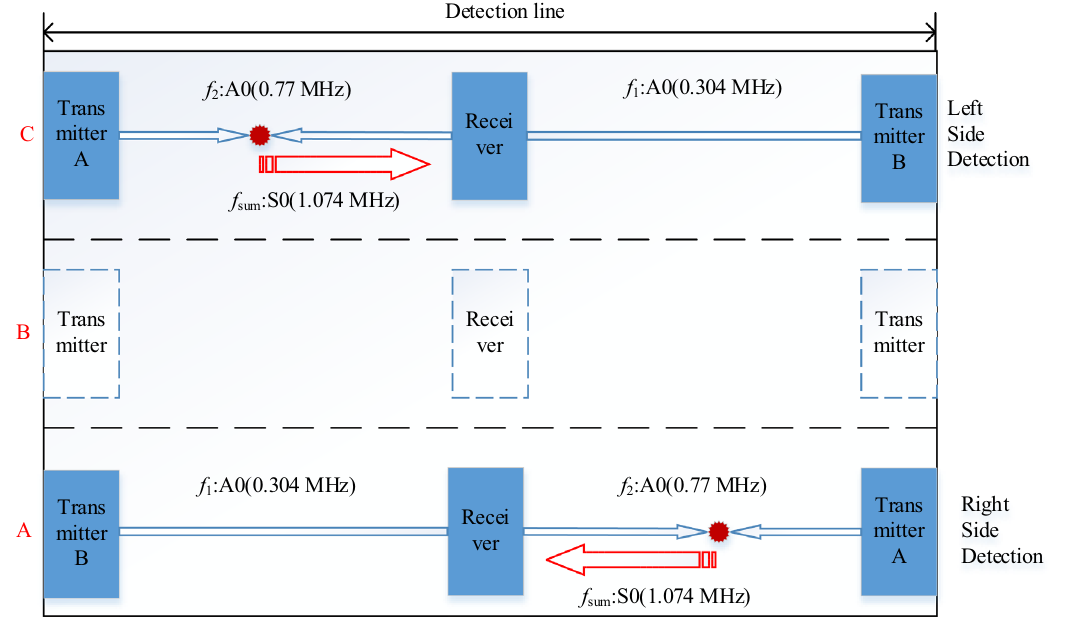
Figure 13 Experimental scheme for stress distribution measurement